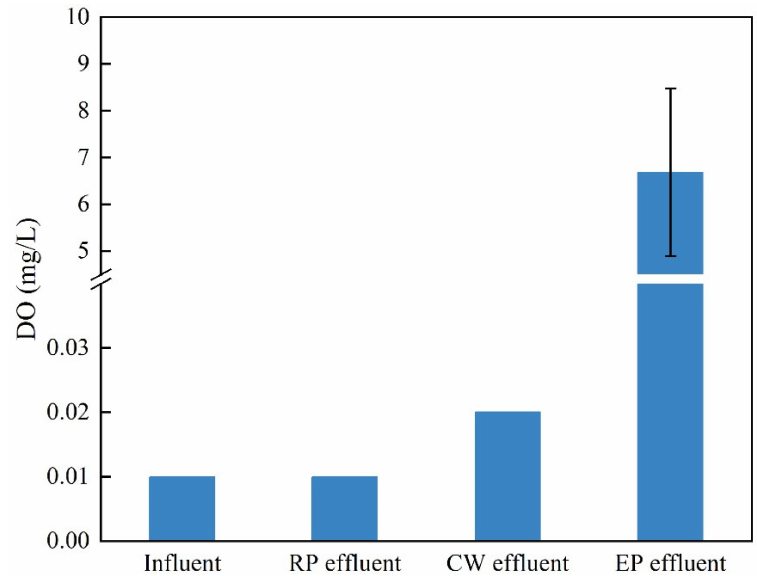
Figure 7. Changes in the DO concentration at different treatment stages (RP: regulation pool; CW: constructed wetland; EP: ecological pond).